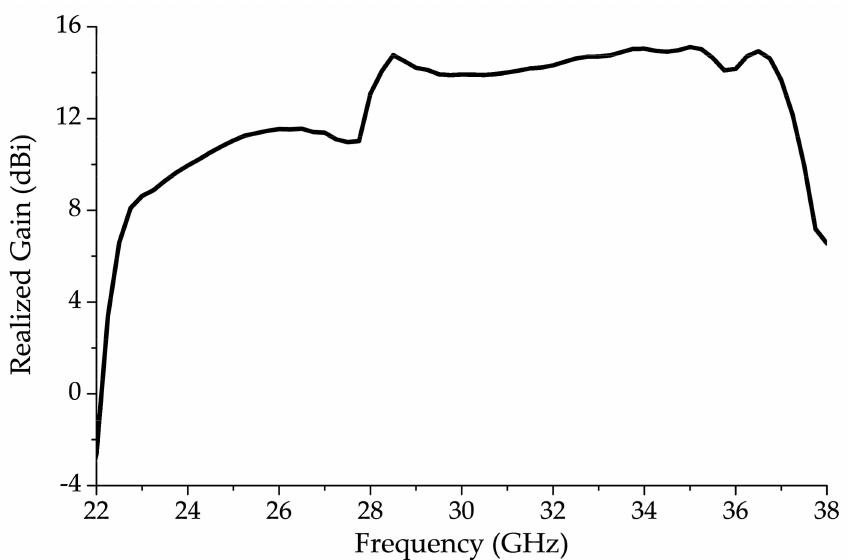
Figure 7. Realized gain of 1-D periodic BAA-LWA with l v = l c = 3.50 mm and w v = 0.76 mm unit-cell showing gain degradation around 28.0